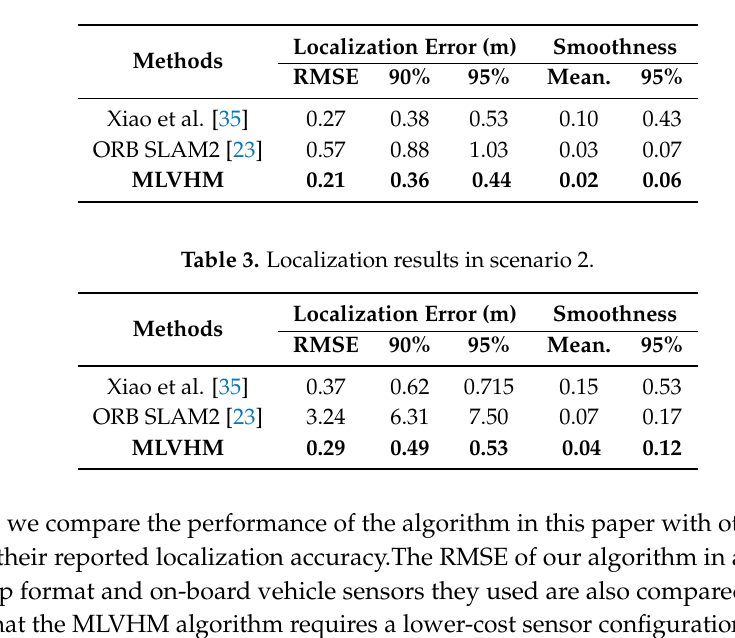
Table 2. Localization results in scenario 1.